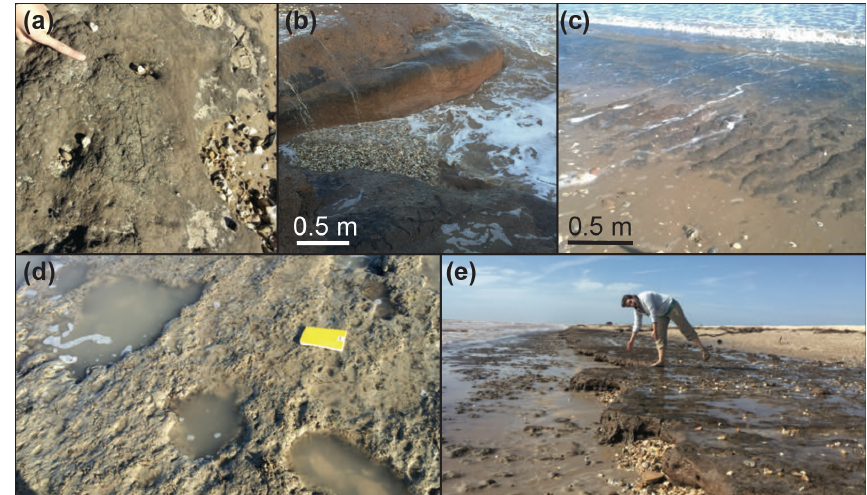
Figure 2. (a) Wetting and drying on the cliff. (b) Focused abrasion creating embayment at the cliff face. (c) Focused abrasion creating runnels on the shore platform. (d) Potholing and pothole coalescence on the shore platform. (e) Differential erosion and abrasion leading to production of a decimeter-scale step on the shore